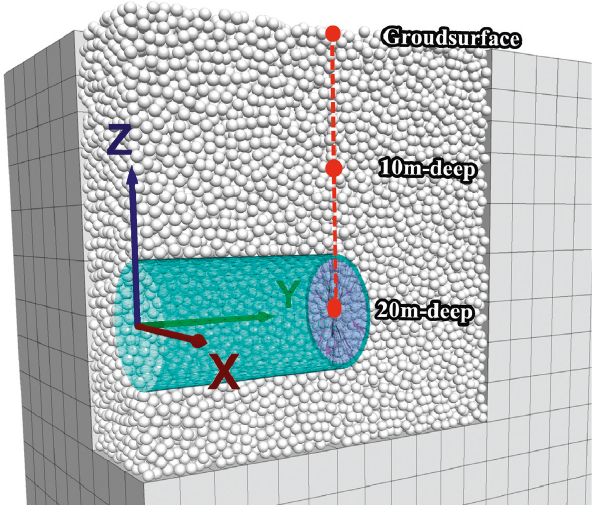
Figure 13: Layout of monitoring points.